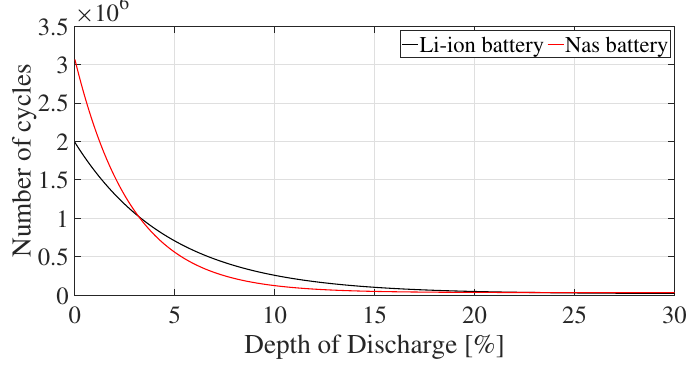
Figure 7. Life cycles vs. depth of